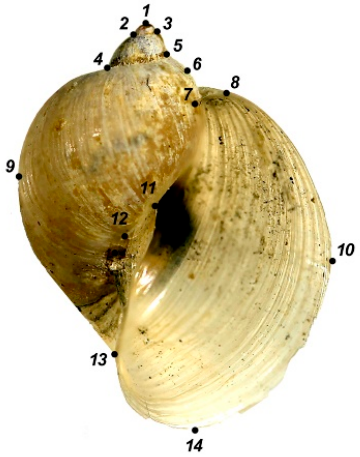
Figure 2. Configuration of landmarks (black dots) used for morphometric analysis of conchological variation in Radix auricularia.